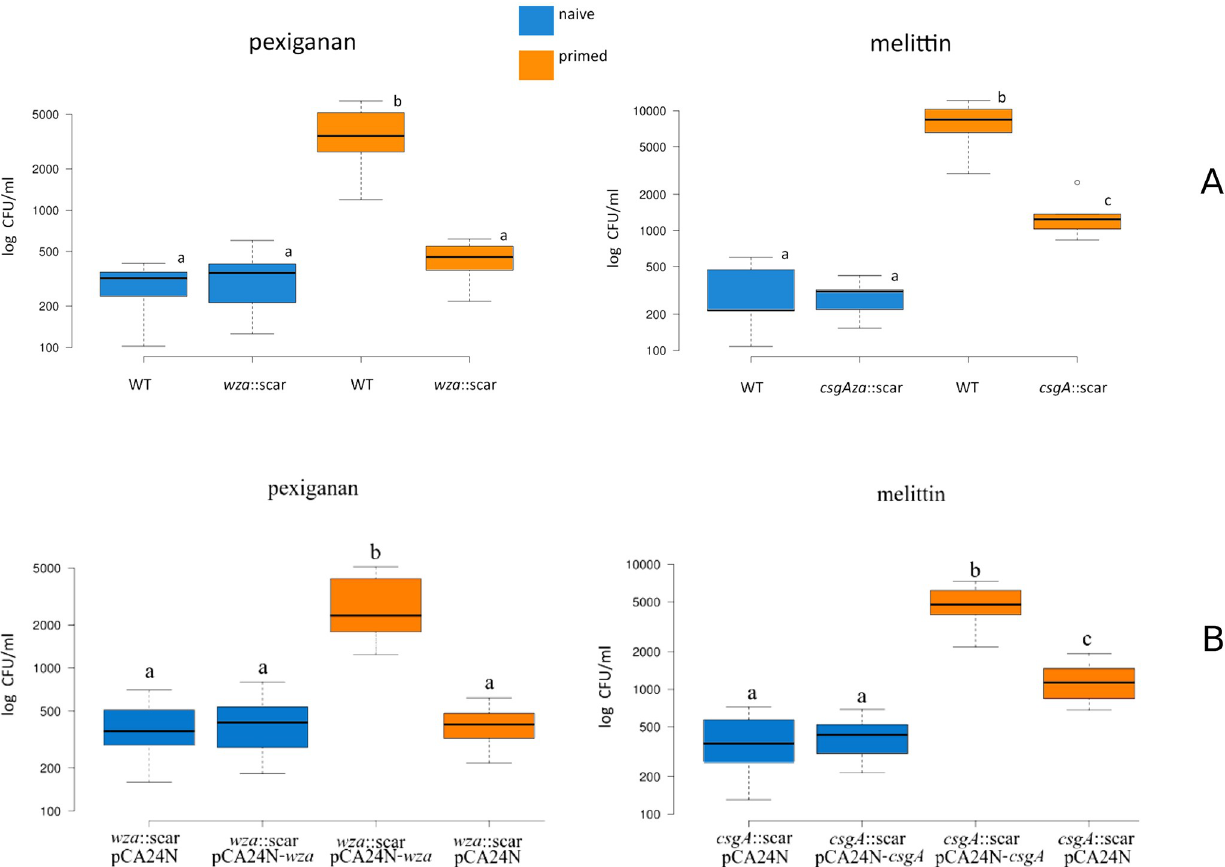
Fig 8. Boxplots data show deficient priming responses of the E . coli MG1655 mutants wza :: scar and csgA :: scar when they are exposed to triggering concentrations of pexiganan and melittin respectively (top panel). Complementation restores the lost priming capacity for both mutants in E . coli MG1655 csgA :: scar and wza ::scar (down panel). The strains were complemented with the plasmids pCA24N - wza and pCA24N -csgA from the ASKA collection. Note that control cells that were transformed with the cloning vector pCA24N show a decreased priming response similar to the one from the mutants. The statistical differences were tested by one-way ANOVA and Dennett’s tests. Different letters highlight significant differences ( p < 0.05).